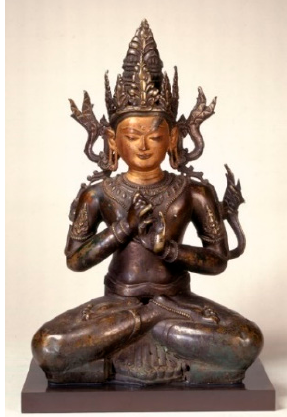
Figure 20. Vairocana Buddha. 14th century, Western Tibet https://himalayanbuddhistart.files.wordpress.com/2015/09/12th-c-tibet-ct-vairocana-c-a-cold-g-61-cm-albuquerque.jpg.